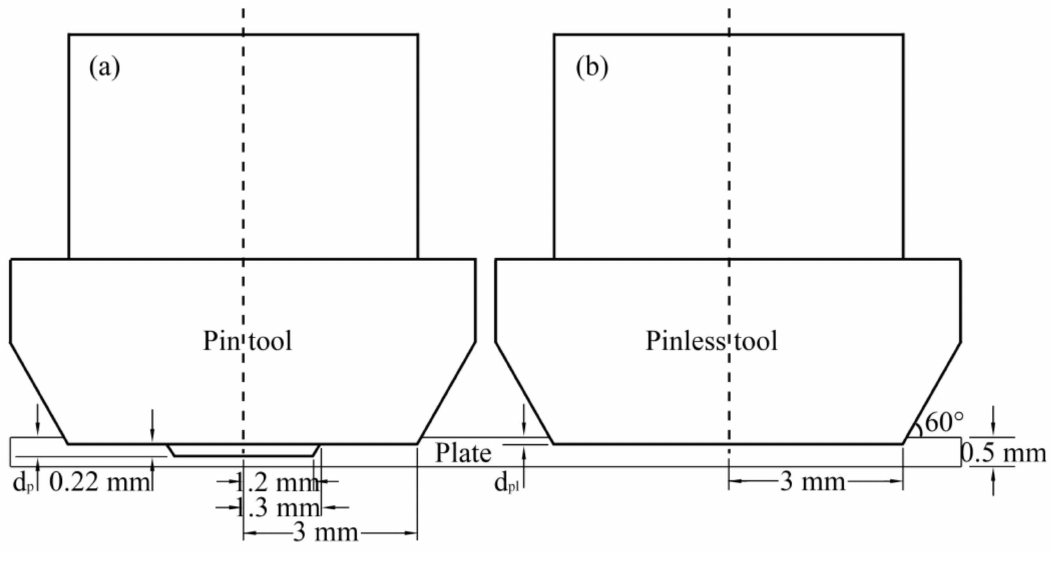
Figure 2. Detailed dimensions of FSW tools: ( a ) pin tool and ( b ) pinless